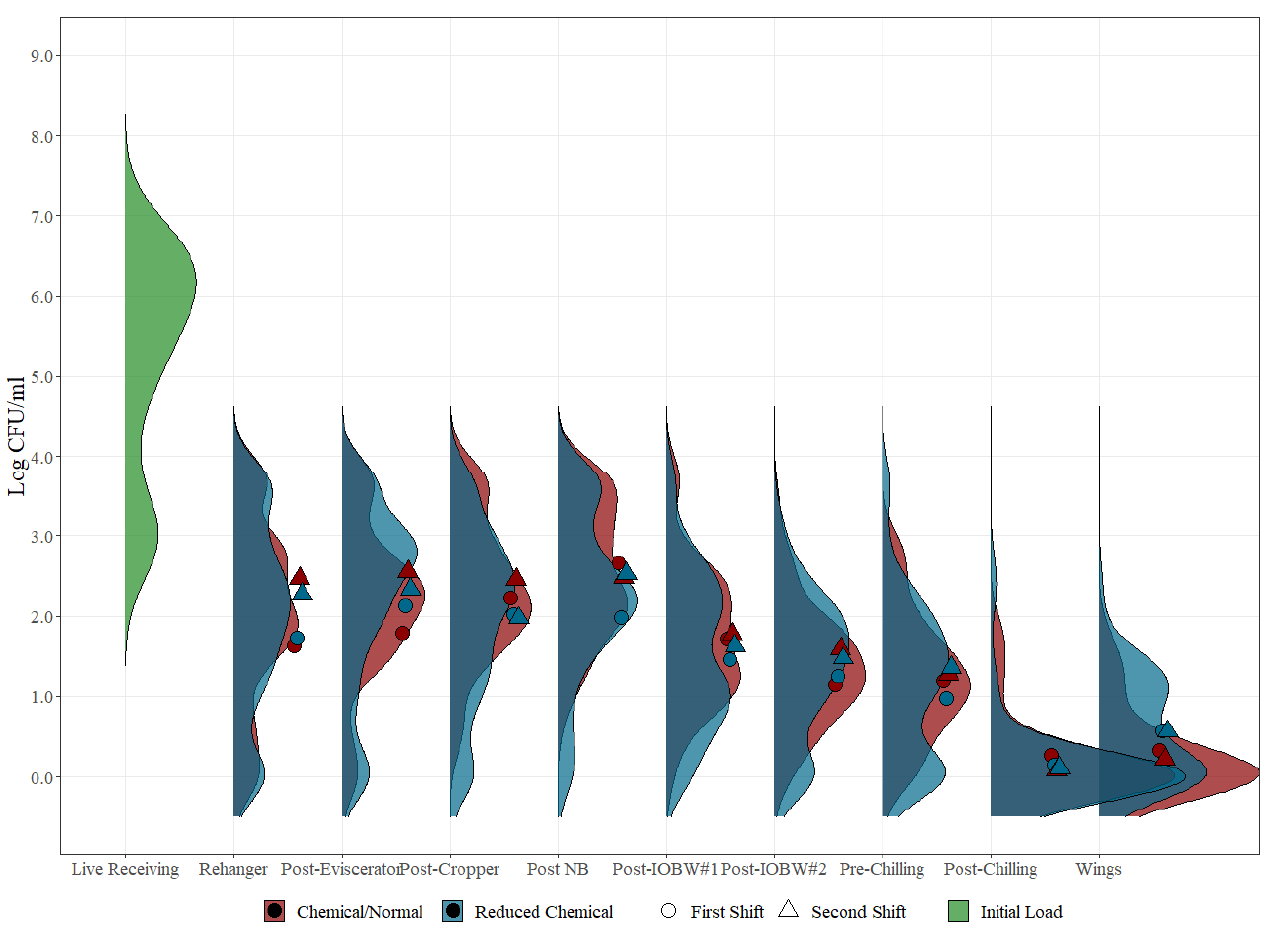
Figure 5. Kernel density estimation for Campylobacter counts (Log CFU/mL) on each of the ten sampling locations evaluated under normal process interventions (red) and reduced chemical process (blue) intervention schemes on whole carcass chicken and part rinses. The dots represent the average value for Campylobacter counts on each sampling location under both process interventions (normal and reduced) during different shifts (circle vs. triangle).